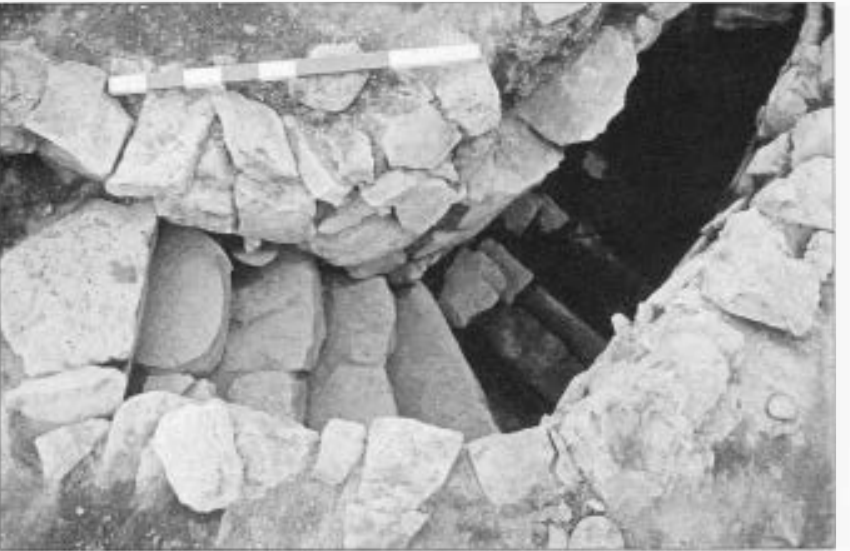
Figure 6 The stone steps at the northern end of the subterranean passageway(scale bar l